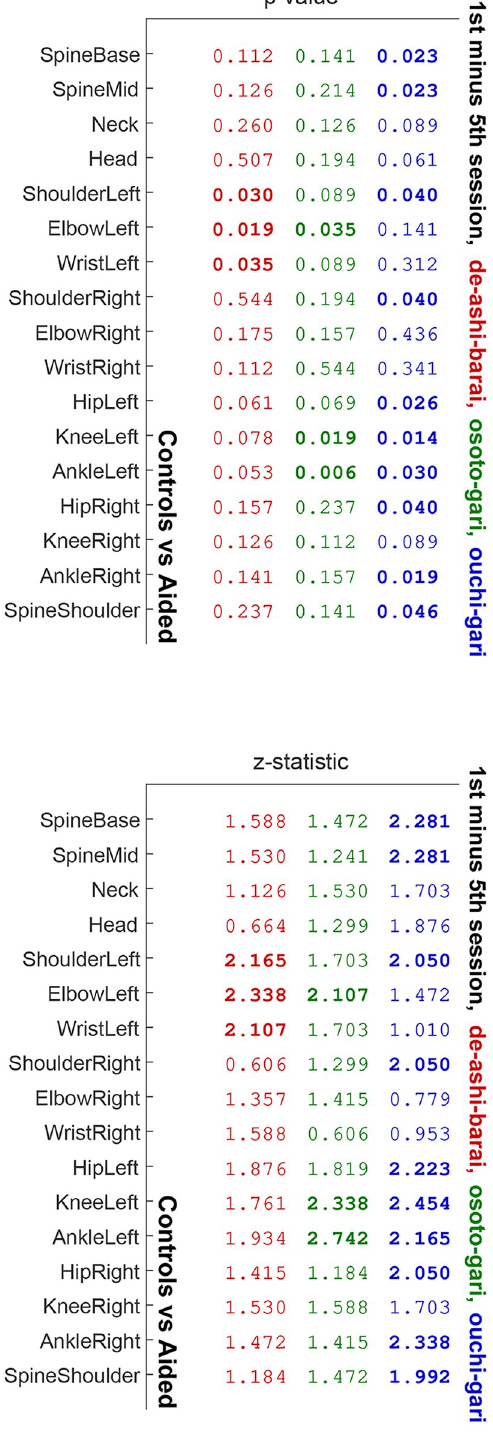
Fig 11. p -values (left) and z -statistics (right) for the comparisons depicted in Fig 8 (in red), Fig 9 (in green), and Fig 10 (in blue). Values are emphasized with bold font when p < 0.05.